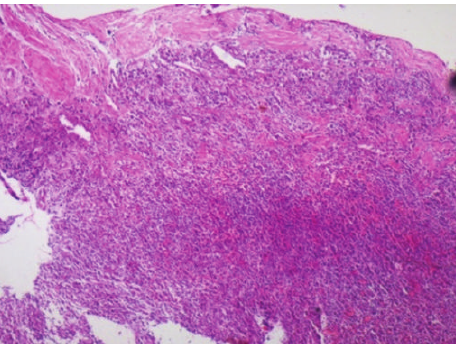
Figure 18: Histopathology report: periapical granuloma.